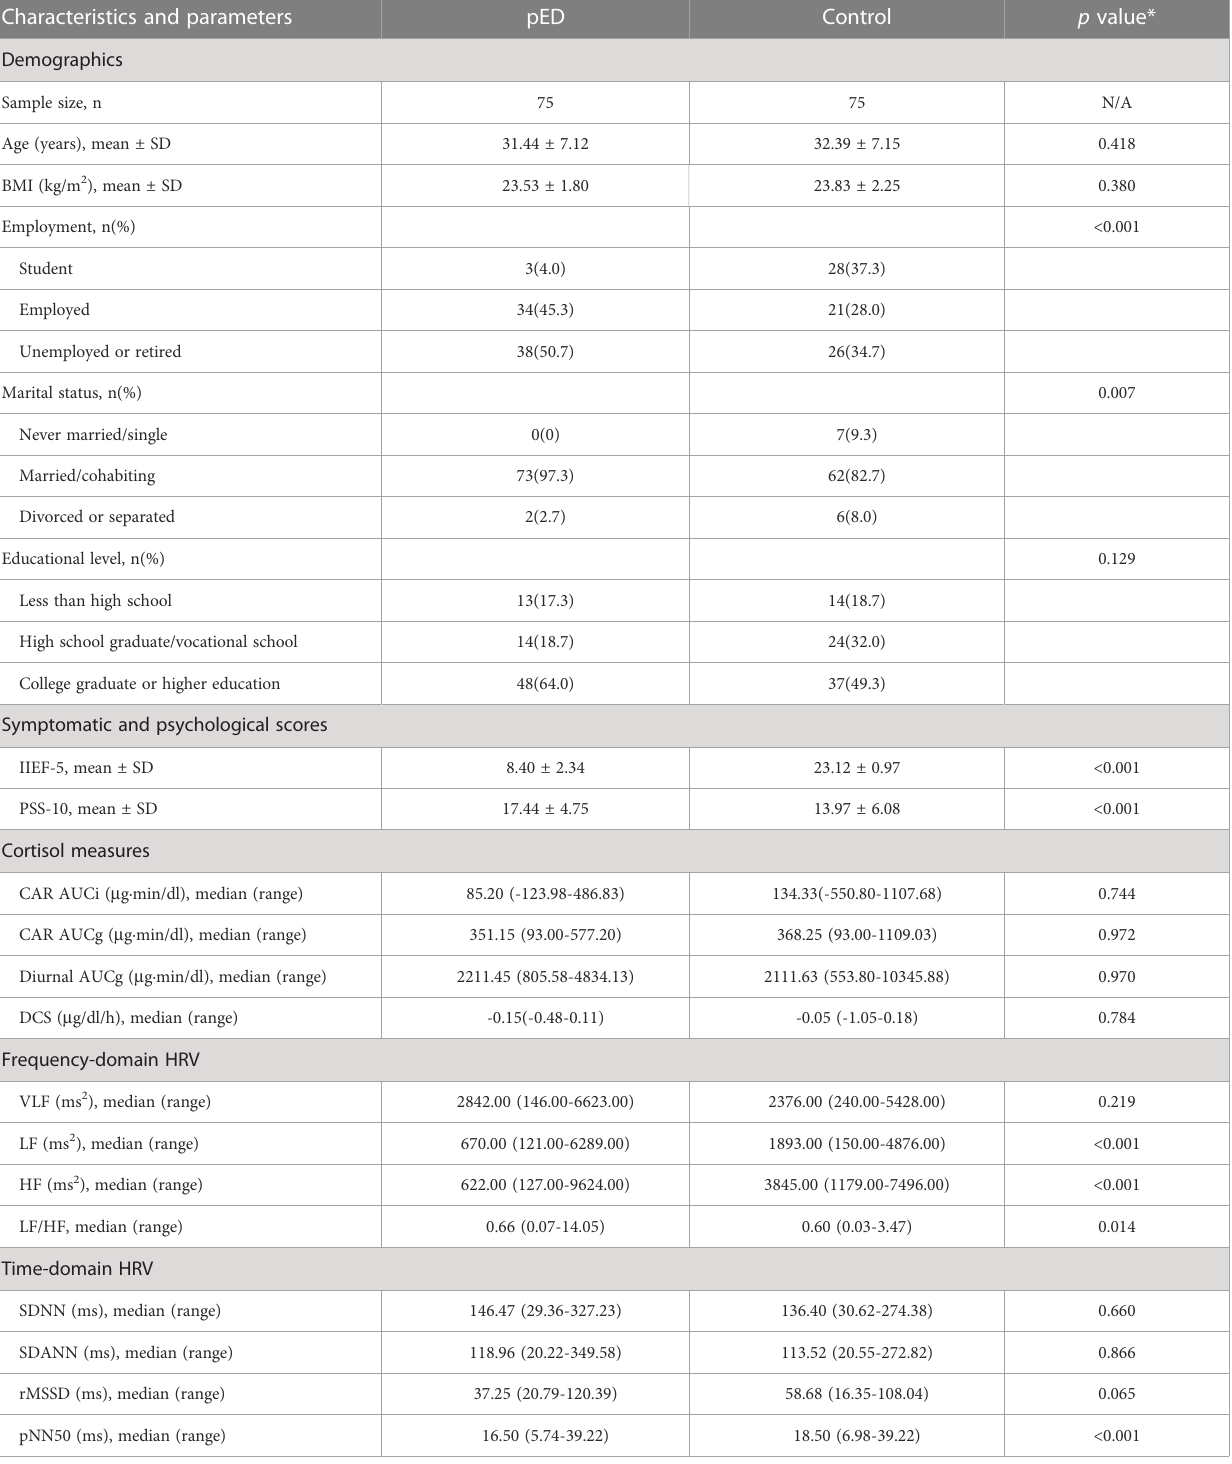
TABLE 1 Descriptive statistics: demographics, symptomatic and psychological scores, cortisol and HRV